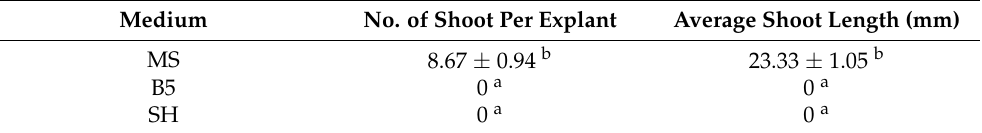
Each value represents the mean ± SD of three independent experiments with 30 explants per treatment. Within columns, means followed by the same letter did not differ significantly according to Tukey’s honestly significant